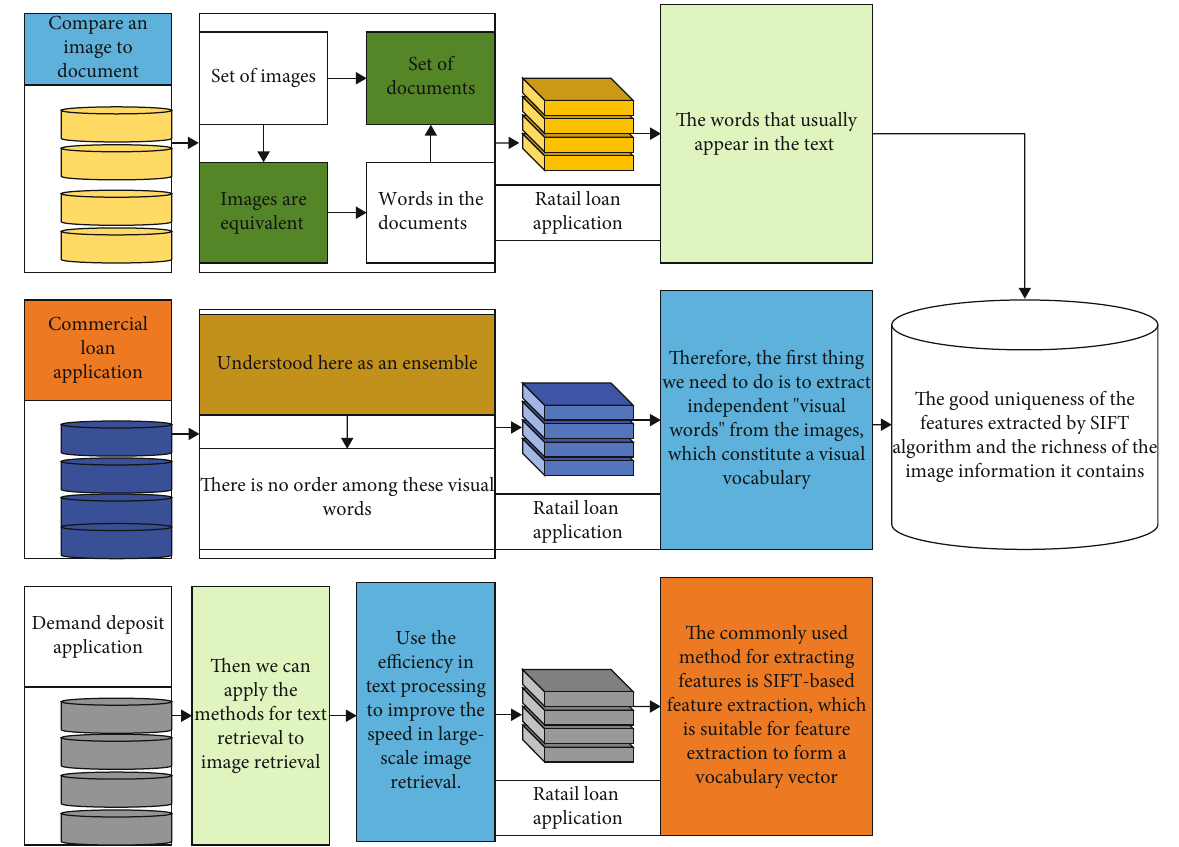
Figure 2: Schematic diagram of local